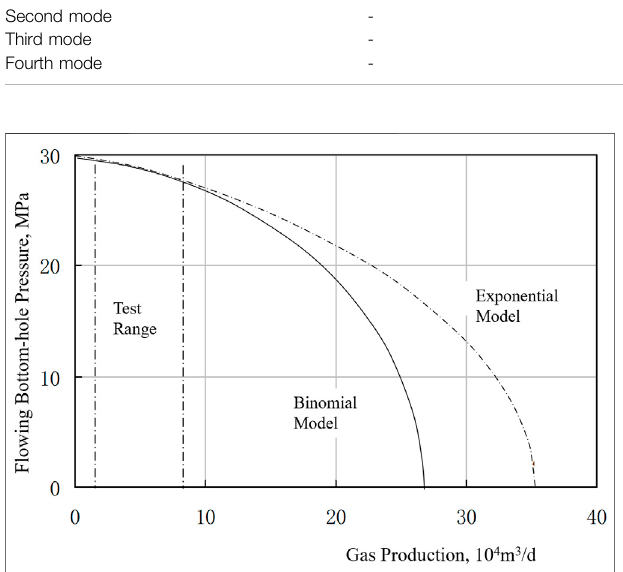
FIGURE 4 | Comparison of in fl ow performance relationship curves produced by different productivity